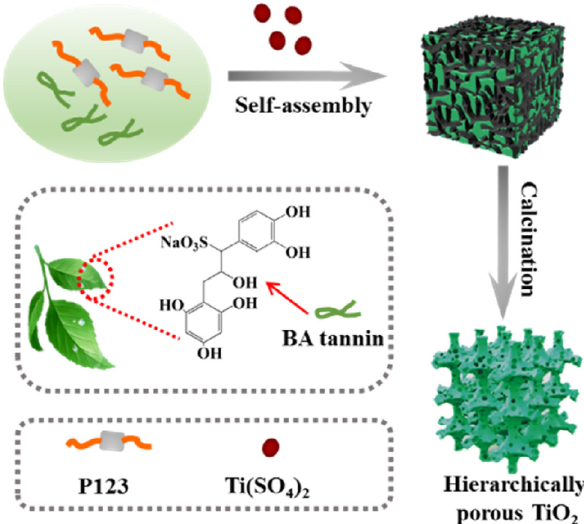
Figure 22: Synthesis steps for porous TiO 2 . Copied with permission from ref. [ 266 ] ; Elsevier, 2020.